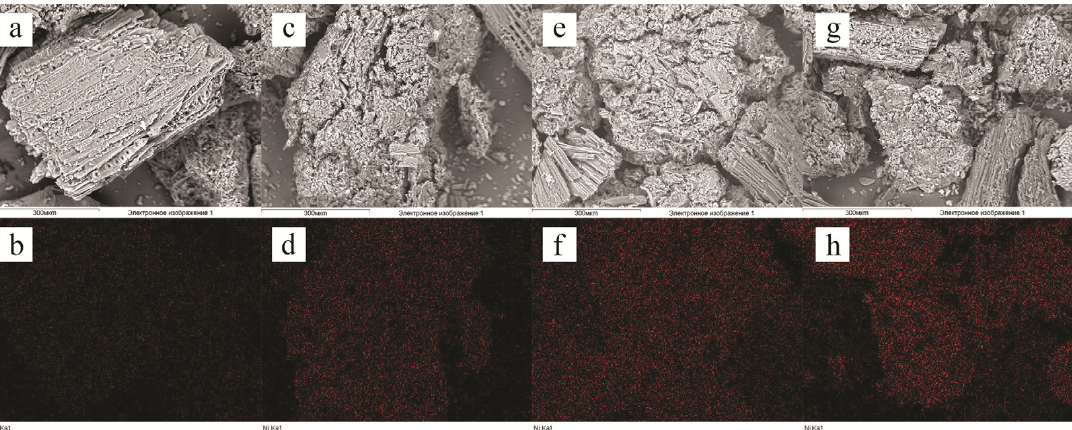
Figure 2. Micrographs ( a , c , e , g ) and nickel mapping ( b , d , f , h ) of the samples of hydrolysis lignin with a mass fraction of nickel of 1%, 3%, 5%, and 7%, respectively.